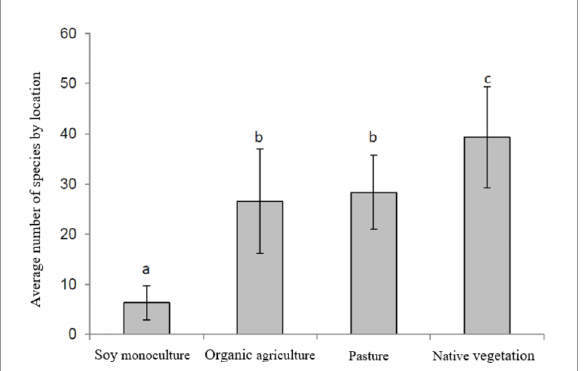
Figure 5: The average number of ant species per location, collected in different habitat types in the Rashad District between June 2019 and August 2020 using a pitfall trap. The bars represent the standard deviation and different letters indicate significant differences ( p <0.05).